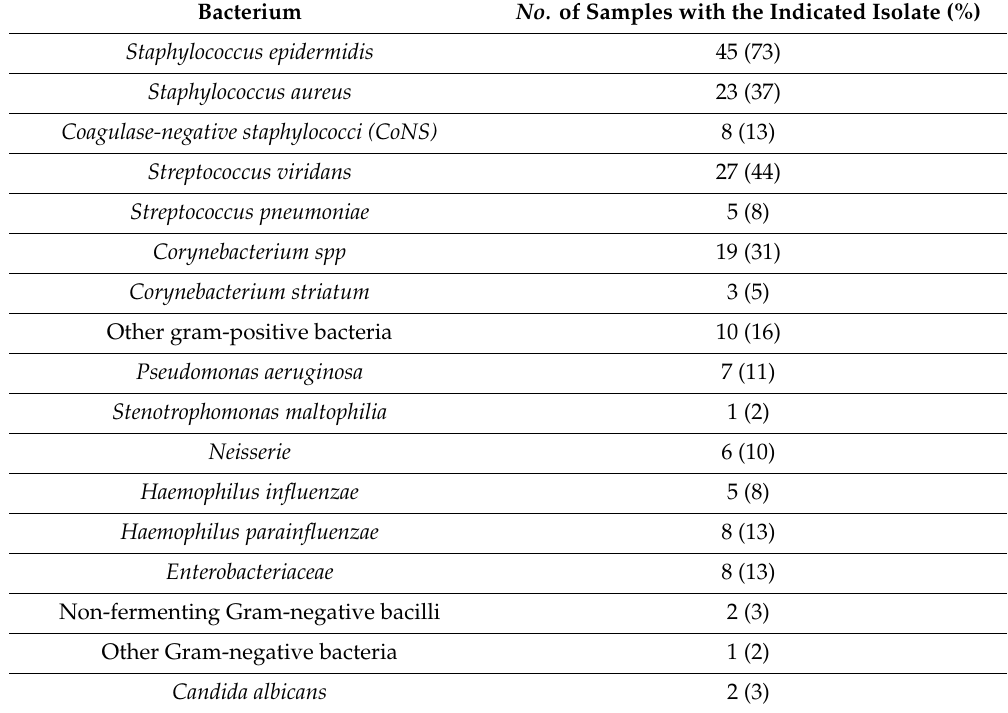
Table 1. Culture results of 62 pre-disinfection samples.